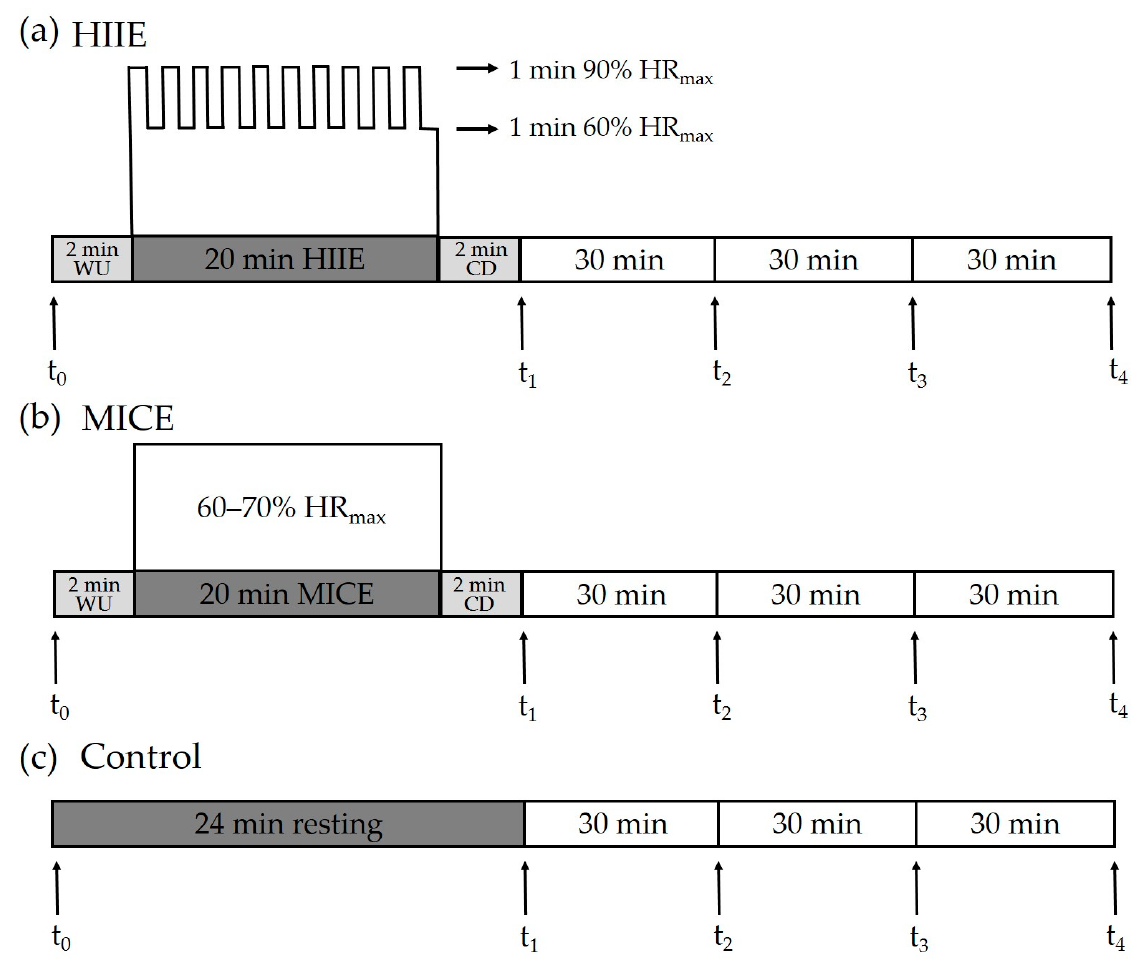
Figure 1. Experimental protocol. Inhibitory control was assessed pre-exercise/at rest (t 0 ) and at four time points after intervention, including immediately (t 1 ), 30 min (t 2 ), 60 min (t 3 ), and 90 min (t 4 ). HIIE: high-intensity interval exercise. MICE: moderate-intensity continuous exercise. WU: warm-up. CD: cool-down.